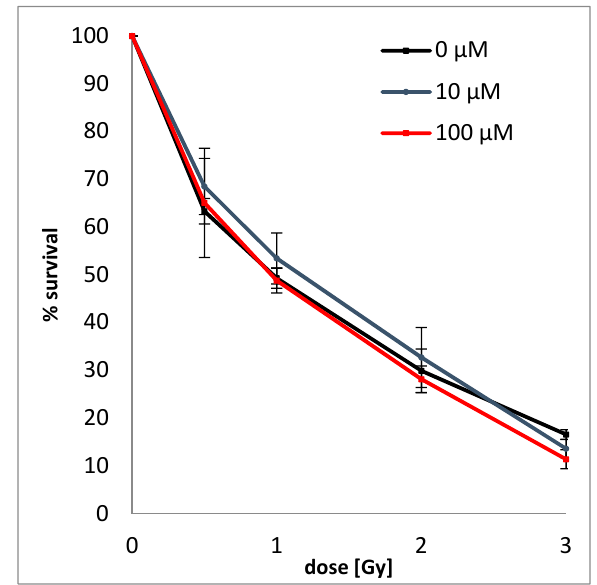
Figure 6. Dose response curves of MCF-7 cells treated with (10 μ M or 100 μ M solutions of BrSdU) or without BrSdU. The average plating efficiencies for the controls with and without pretreatment are equal to 28.16% (0 μ M), 25.63% (10 μ M), and 24.78% (100 μ M). Experiments were performed at least in two independent experiments in duplicate and the results are expressed as mean ± standard deviation.